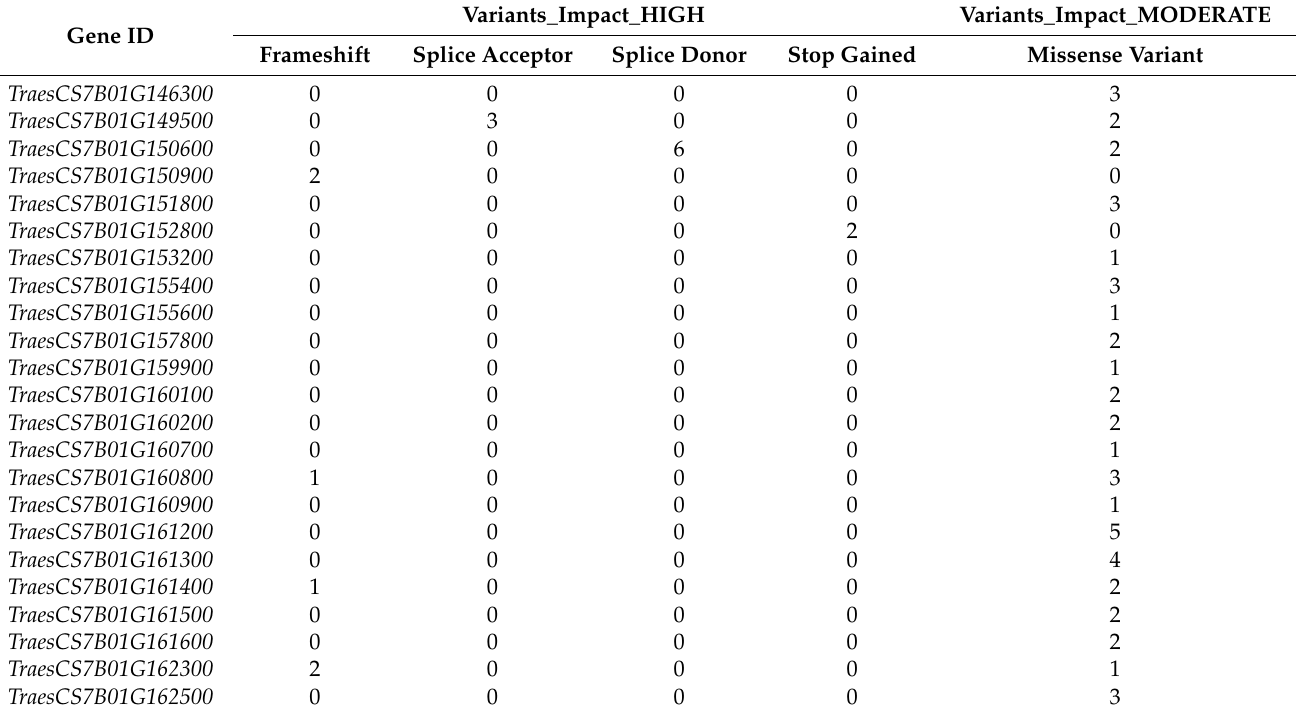
Table 2. The effects of genetic variations in the Pm40 region predicted by mutation annotation.